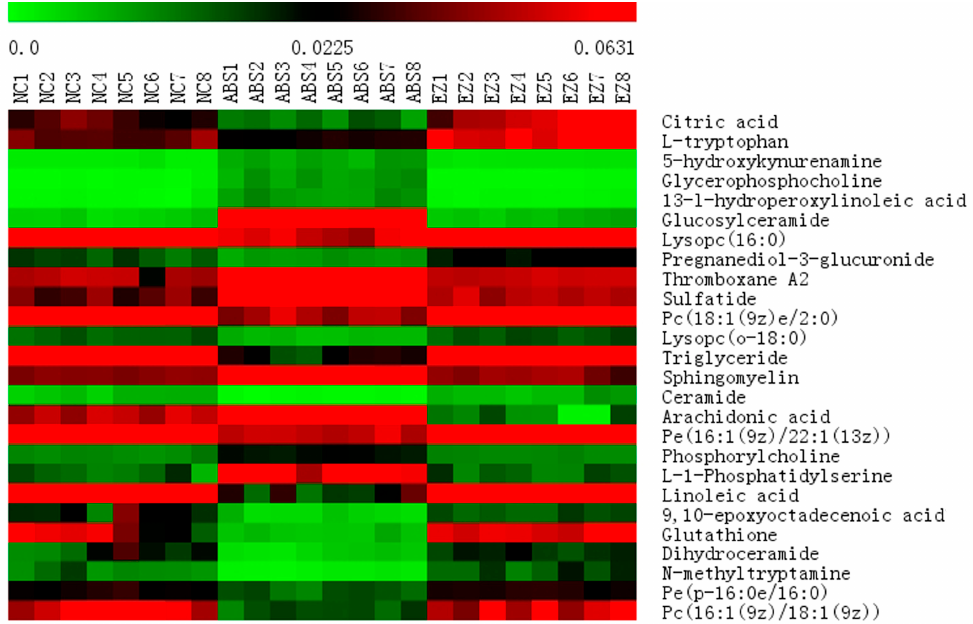
Figure 7. Compound-target-metabolic pathway network.